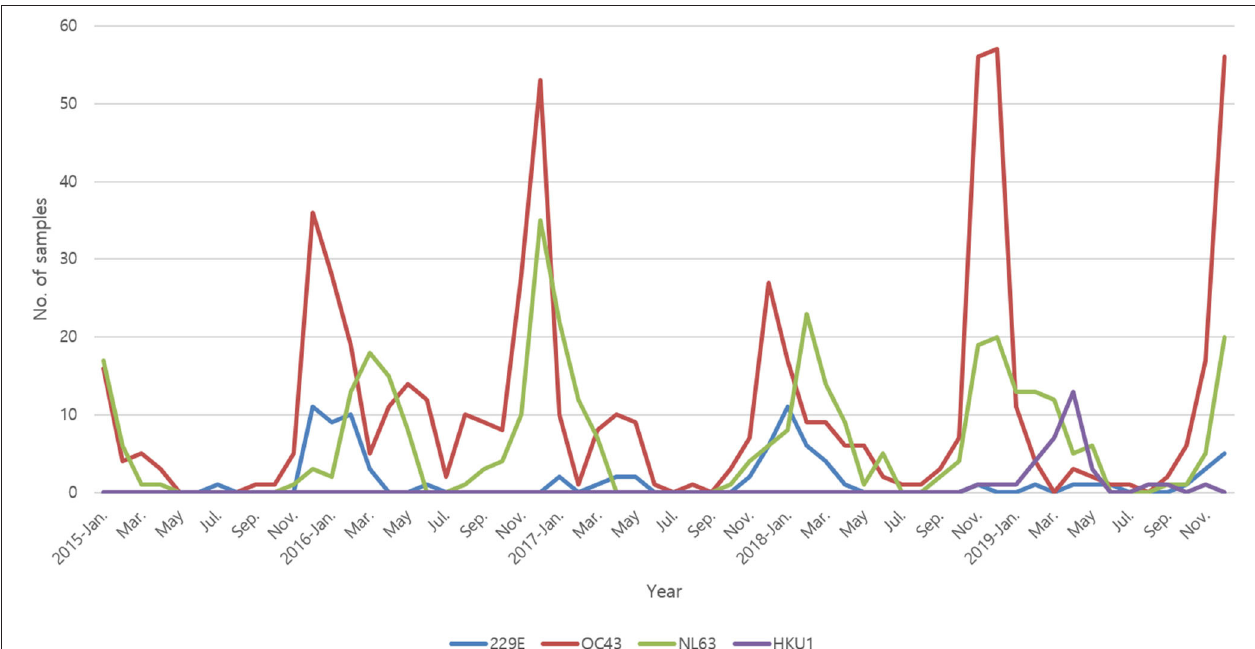
FIGURE 1 | Monthly distribution of HCoVs between January 2015 and December 2019.